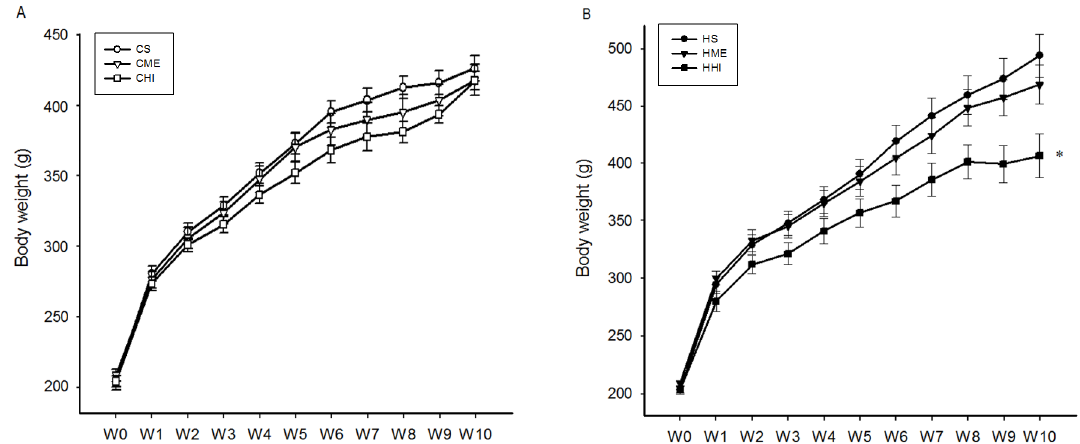
Fig 1. Body weight changes in the CD group and the HFD group during the 10-weekintervention period. A. Body weight increasedin the CD groups duringthe 10-weekintervention, howeverthere was no mean difference amongthe CD groups. B. Body weight increasedprogressivelyin the HFD groups, though the magnitudes and rates were considerably different among the three groups, with a significantdifference in weight gain observedin the HS comparedwith the HHI group. CS = control diet and sedentary; CME = control diet with ME exercise; CHI = control diet with HI exercise; HS = high- fat diet and sedentary; HME = high-fatdiet with ME exercise; HHI = high-fat diet with HI exercise.Statistical significance using repeatedmeasures ANOVA: * vs sedentary group ( * , P <